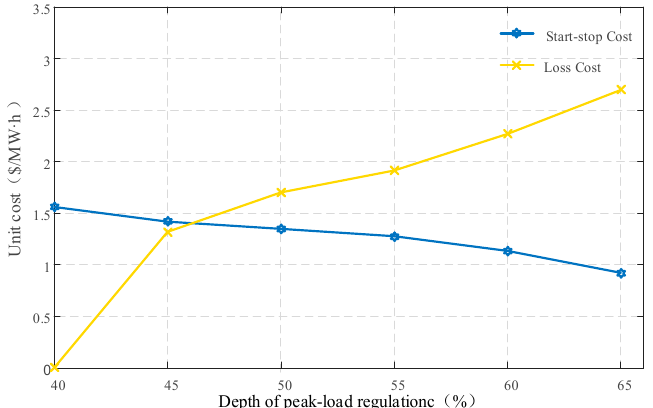
Figure 6. Start–stop cost and loss cost curves of thermal power units at different peak load adjustment depths. Table 2. Improved BA parameter initialization settings.